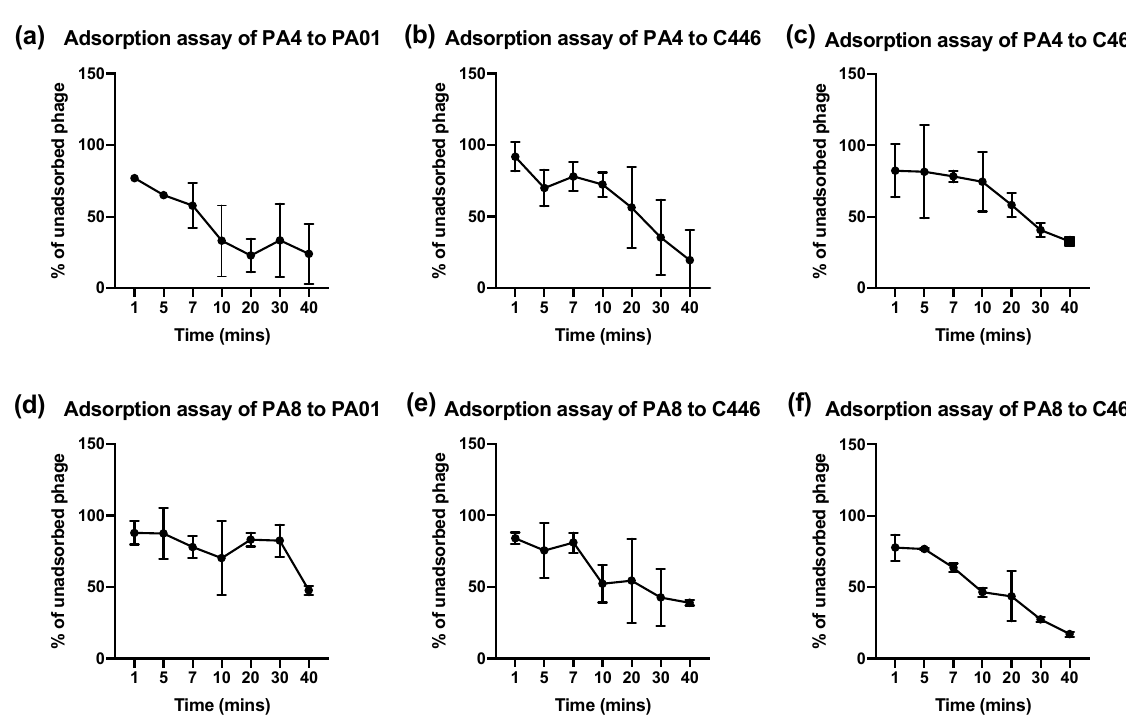
Figure 2. Determining Percentage of Unadsorbed Bacteriophage to Host Bacterial Surface. Plaque forming units per mL (PFU mL −1 ) was measured for PA4 and PA8 at 1 min, 5 min, 7 min, 10 min and every 10 min thereafter for 40 min against PA01 reference strain ( a , d ), 1 non-CF (C446) CI ( b , e ) and 1 CF (C462) CI ( c , f ) to determine the percentage of unadsorbed phage of the total phage inoculum. Data expressed as mean ± SEM for three independent experiments.